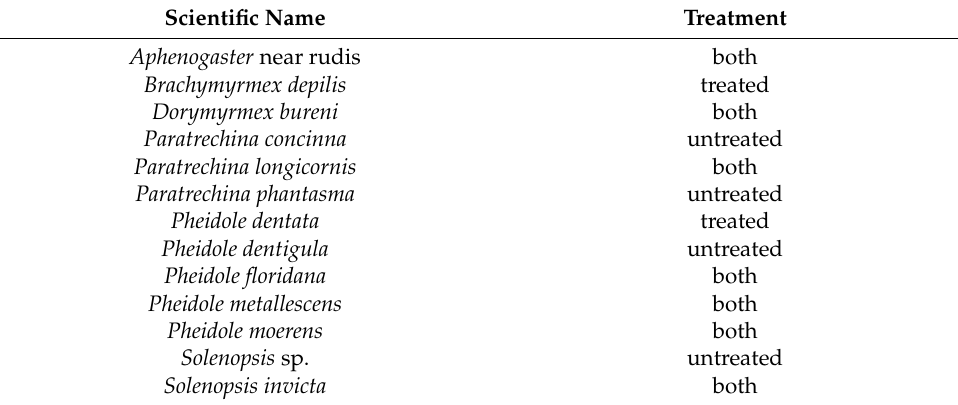
Figure 4. Mean ( ± 1 SE) ant (excluding fire ant) species Shannon diversity indices collected from burrow bait at five pairs of treated and untreated study sites at CSJFTC, 1998–2000. There were no significant differences between study sites from a randomized block design ANOVA (F 1, 8 = 0.14, P = 0.722). Asterisks on the x-axis indicate when treatments occurred. Table 2. Ant species (Hymenoptera: Formicidae) found using burrow baits at all study sites on CSJFTC, 1998–2000. “Treated” refers to species found only on sites treated to reduce fire ant popula- tions, “untreated” refers to species found only on untreated sites, and “both” refers to species found on both treated and untreated